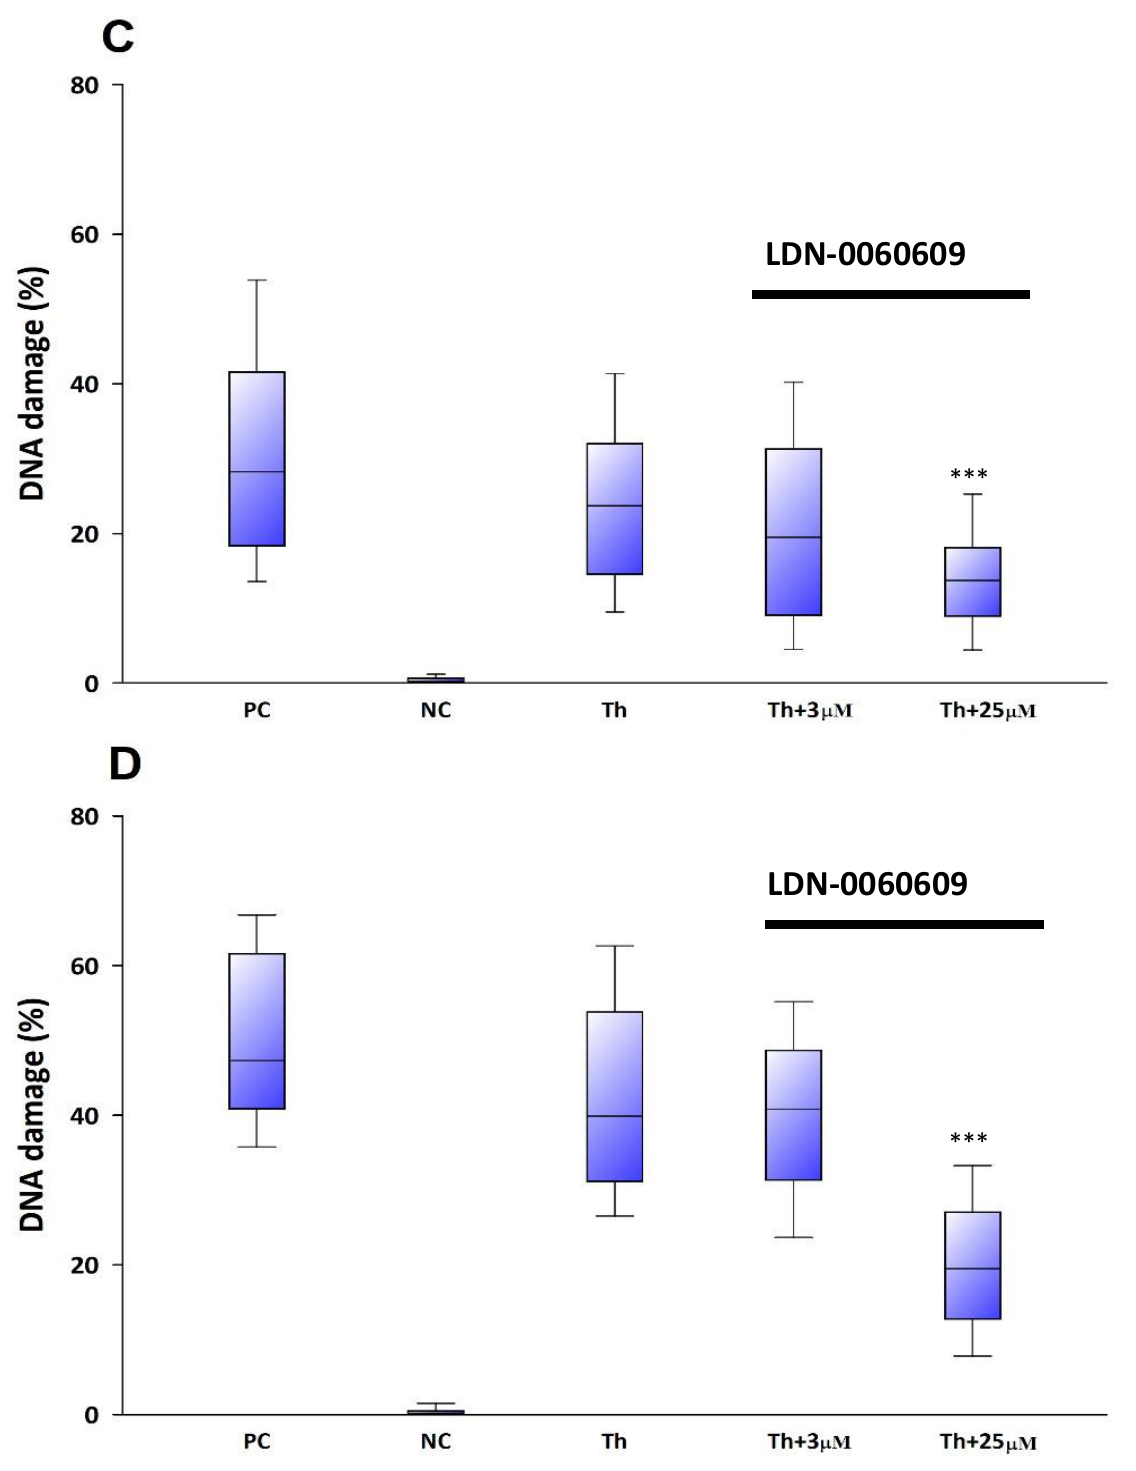
Figure 6. Analysis of genotoxicity in HTM cells treated only with the PERK inhibitor LDN-0060609 after 24 h ( A ) and 48 h ( B ) and HTM cells treated with Th and PERK inhibitor LDN-0060609 after 24 h ( C ) and 48 h ( D ) by the comet assay. Each of the statistical analyses in the individual experiments was based on the results of three independent tests. The value of cells scored for each individual was 100. Box plots show median, 25–75 percentile, minimum and maximum values. On the graphs, the differences were statistically significant as follows: *** p < 0.001 versus the negative control (NC) ( A , B ) and versus Th ( C , D ). PC—positive control; DMSO—dimethyl sulfoxide;